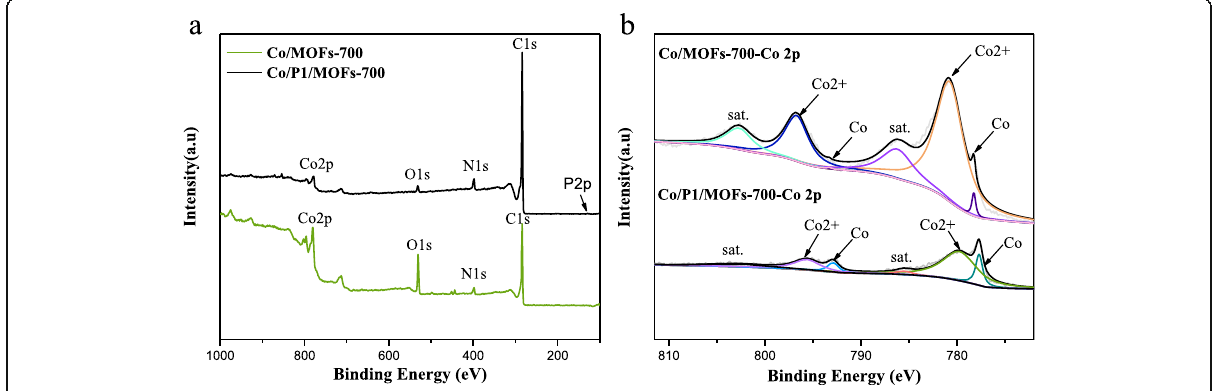
Fig. 3 a XPS spectra survey of Co/MOFs-700 and Co/P1/MOFs-700. b Co 2p spectra of Co/MOFs-700 and